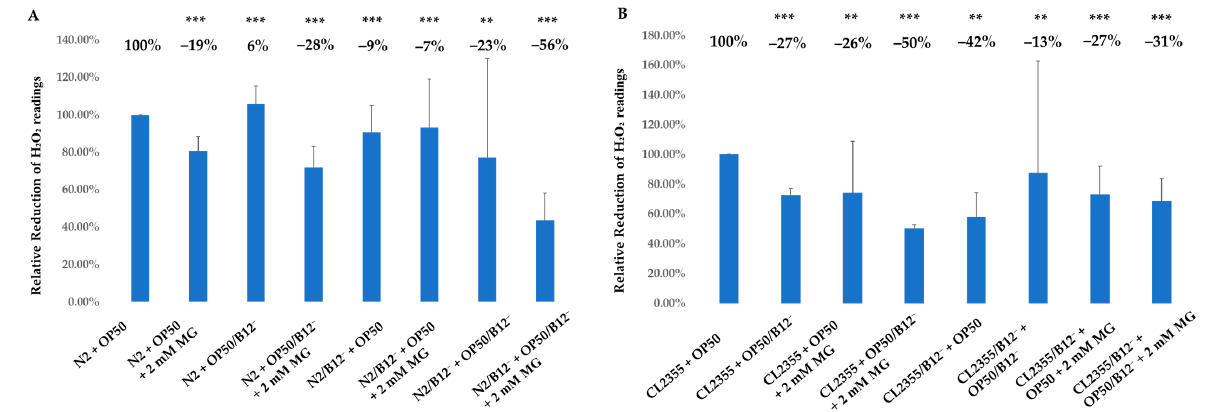
Figure 6. Antioxidant activity of mogrosides in N2, N2/B12 − , CL2355 and CL22355/B12 − worms. ( A ) Synchronized N2 and N2/B12 − worms were hatched and grown on either OP50 or OP50/B12 − in the presence or absence of 2 mM mogrosides. ( B ) Synchronized CL2355 and CL22355/B12 − worms were hatched and grown on either OP50 or OP50/B12 − in the presence or absence of 2 mM mogrosides. N2 and CL2355 worms were collected at the L4 stage and assayed for ROS. Three independent experiments were used to calculate the standard deviations. The Student t -test was conducted to assess the statistical significance between the treatments and the non-treated N2 ( A ) and CL2355 ( B ) worms (** p < 0.01); *** p < 0.001.